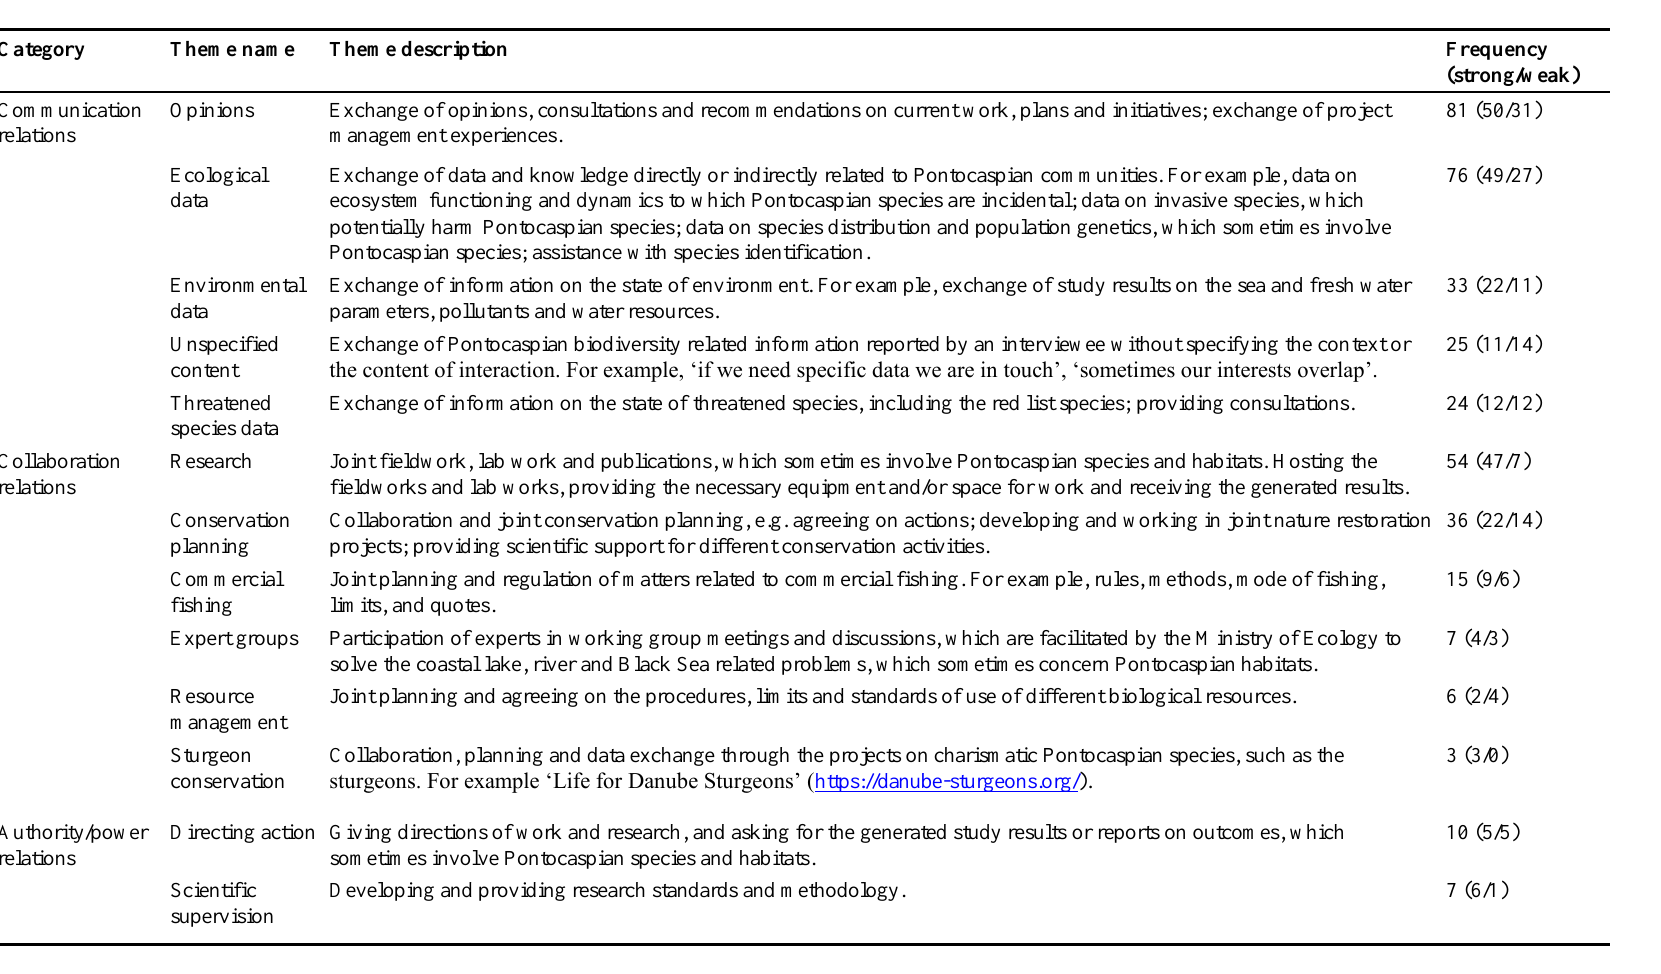
Table A2.1. Identified themes of stakeholder interactions and their descriptions. ‘Frequency’ reports the number of mentioning of identified themes by the interviewees. The numbers in brackets reflect how many times the theme was associated to strong vs. weak relational